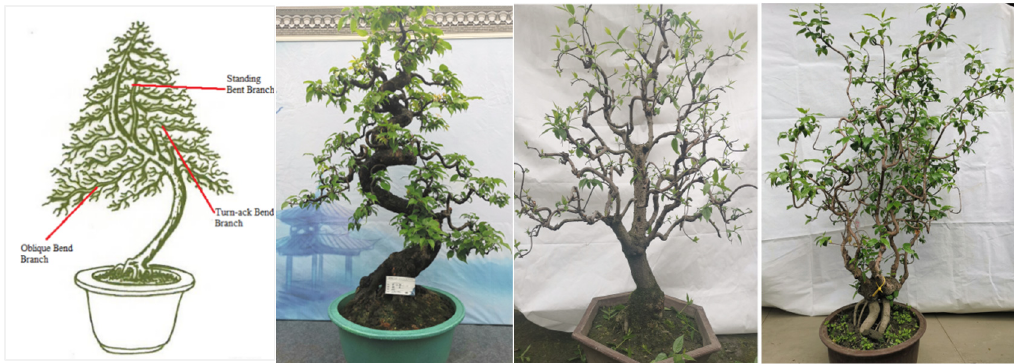
Figure 9. Three branch-making styles (SBB, OBB, and TBB) for the rolling-branch bonsai. Note: SBB: Standing Bent Branch (Chinese name ‘ 立弯枝 ’); OBB: Oblique Bent Branch (Chinese name ‘ 斜弯枝 ’); TBB: Turn-back Bent Branch (Chinese name ‘ 回曲枝 ’).